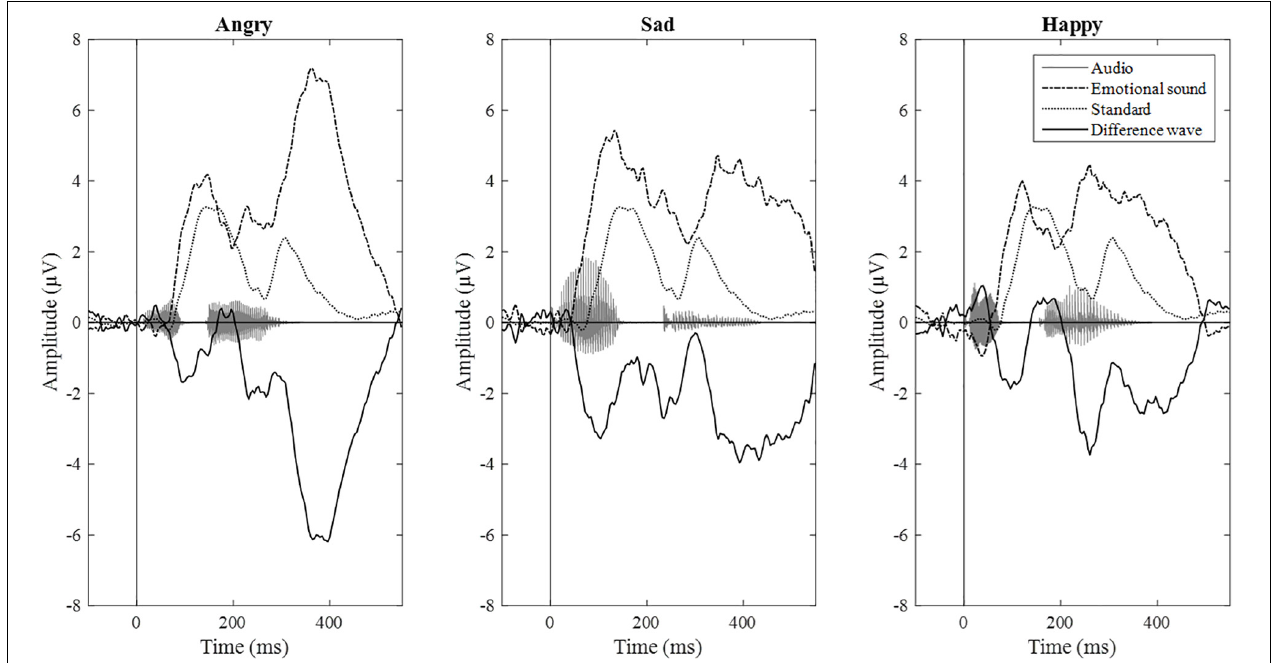
FIGURE 2 | ERP waveforms from F-electrodes (F3, Fz, and